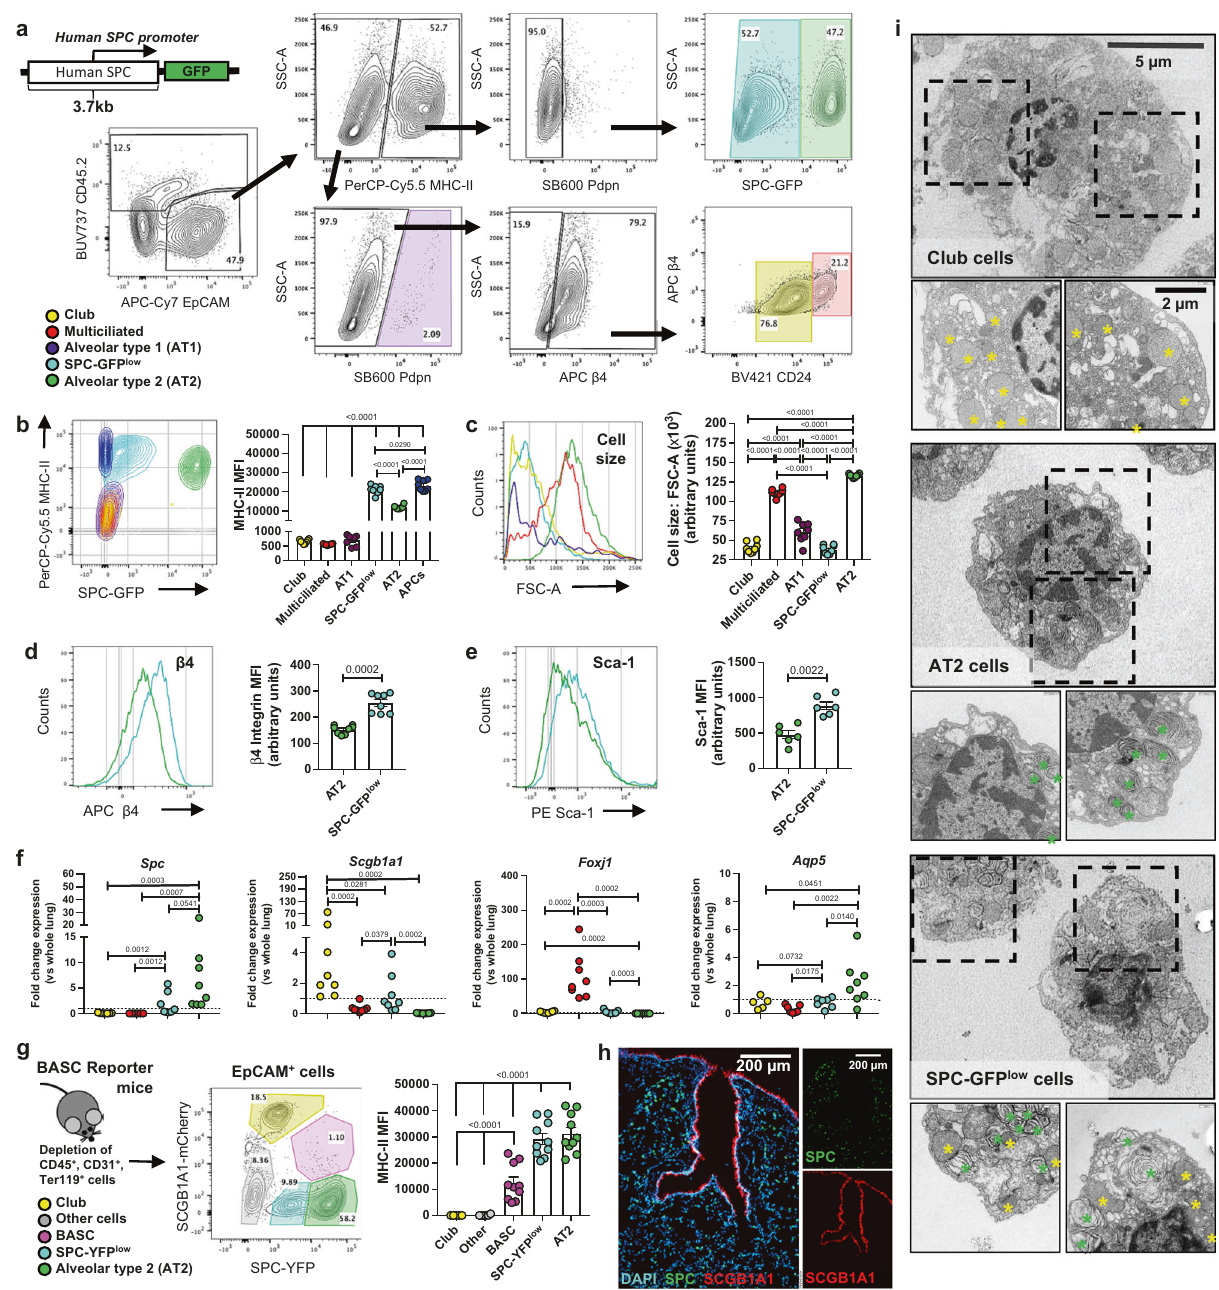
Fig. 1 In addition to AT2 cells, MHC-II is highly expressed by SPC low MHC high LECs. a Genetic construct of SPC-GFP mice and gating strategy to identify major LECs including club ( yellow ), multiciliated ( red ), alveolar type 1 (AT1, purple ), SPC low ( blue ), alveolar type (AT2, green ) lung epithelial cells in SPC-GFP mice. b Contour plot and quanti fi cation of LEC MHC-II. CD45 + CD24 + MHC-II + APCs depicted in dark blue . One-Way ANOVA with Holm-Sidak ’ multiple comparison test. c Histogram and quanti fi cation of LEC cell sizes, One-Way ANOVA with Holm-Sidak ’ s multiple comparison test. Histogram and quanti fi cation for d airway epithelial marker β 4 integrin and e stem cell antigen, Sca-1 by SPC-GFP low and AT2 cells, two-tailed Mann – Whitney test. f mRNA levels of select lineage-de fi ning transcripts in sorted LECs, two-tailed Mann – Whitney test. Sorting strategy is the same as gating strategy in Fig. 1a. g Contour plot for identi fi cation of distinct LECs in bronchioalveolar stem cell (BASC) reporter mice and quanti fi cation of LEC MHC-II, One-Way ANOVA with Tukey ’ s multiple comparison test. Major LECs including club ( yellow ), BASC ( magenta ), SPC low ( blue ), alveolar type (AT2, green ), and other cell (gray) are indicated. h Representative immuno fl uorescent micrograph showing anatomical location of SPC-YFP + cells ( green ) and SCGB1A1-mCherry + ( red ) with DAPI ( blue ) used as counterstain. Data is representative of n = 2 mice, 2 experiments. i Representative transmission electron micrographs for LECs sorted and pooled from n = 3 SPC-GFP mice. Experiment was repeated twice. Yellow asterisks indicate electron-dense secretory vesicles and green asterisks depict lamellar bodies. All data have n ≥ 5 mice, two independent experiments. All data are presented as mean ±